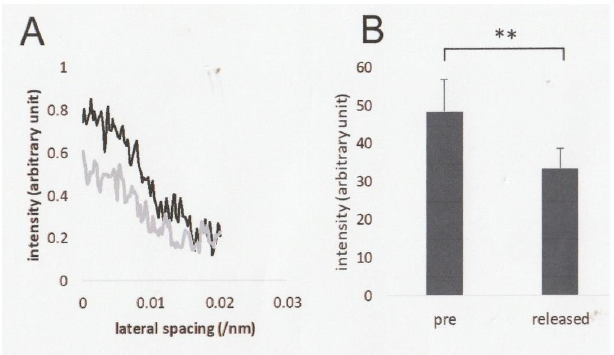
Figure 2. ( A ) Intensity profiles of the 14.3nm meridional reflection before (black line) and after (grey line) ramp-shaped releases. ( B ) Mean intensity values of the 14.3 meridional reflection before (left) and after (right) ramp-shaped releases. Vertical bars indicate SEM ( n = 8), while horizontal bar with ** indicates significant difference ( p < 0.01) between the two mean values.